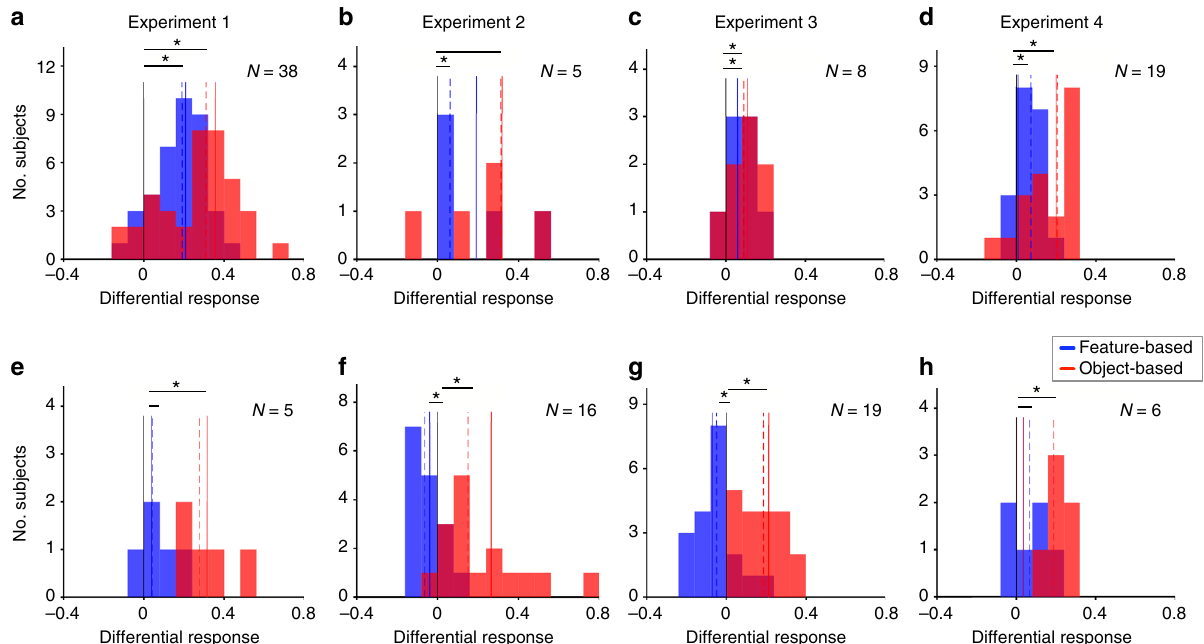
Fig. 4 Subjects who adopted feature-based learning updated their preference even for other objects that contained a feature of the object selected on the previous trial based on the reward outcome. a – d Plotted are the feature-based (blue) and object-based (red) differential responses for subjects who adopted feature-based learning in a given experiment. The dashed lines show the median values across subjects and a star indicates signi fi cant difference from zero (one-sided sign-rank test, P < 0.05). The solid lines show the average simulated differential response using the estimated parameters based on the fi t of each subject ’ s data. e – h The same as in a – d but for subjects who adopted object-based learning in each